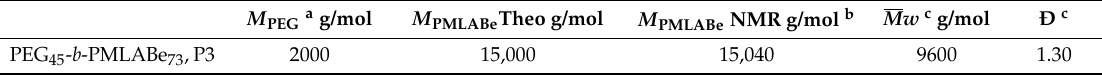
Table 2. Characteristics of the PEG 45 -b-PMLABe 73 (P3).